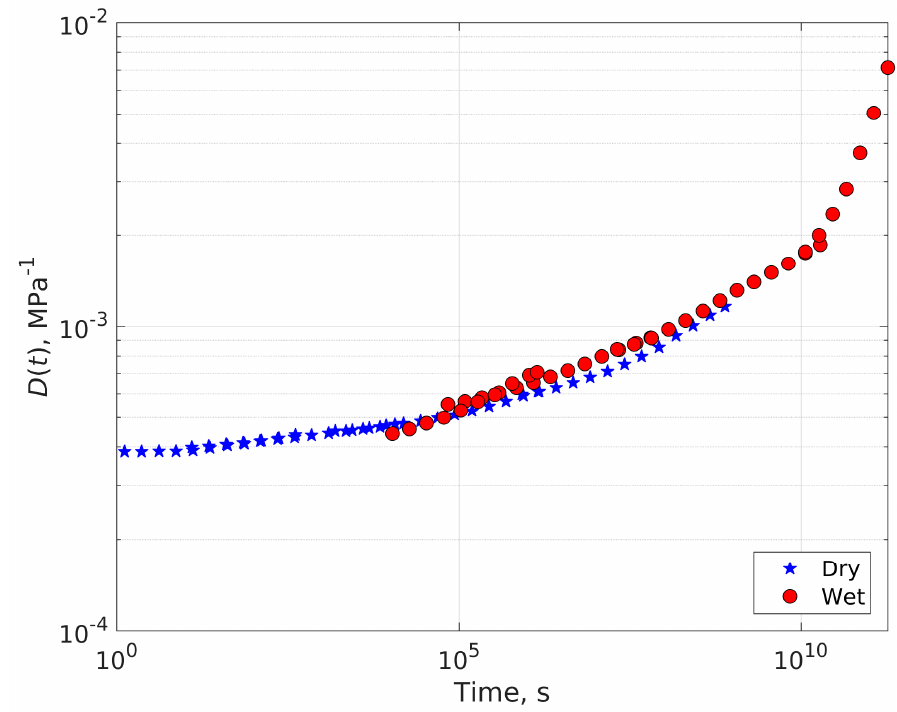
Figure 6. Complete dry-to-wet creep compliance master curve. Dry material as a reference state. σ = 10 MPa.